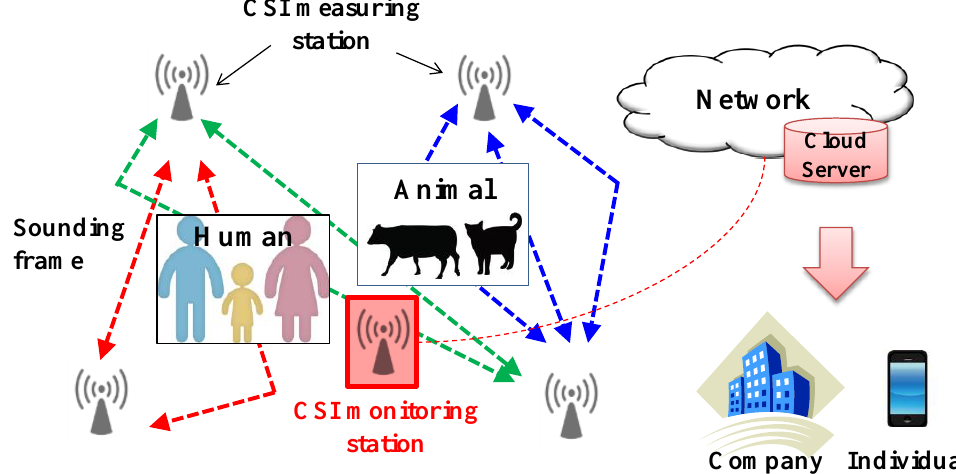
Figure 3. Concept of the proposed system.